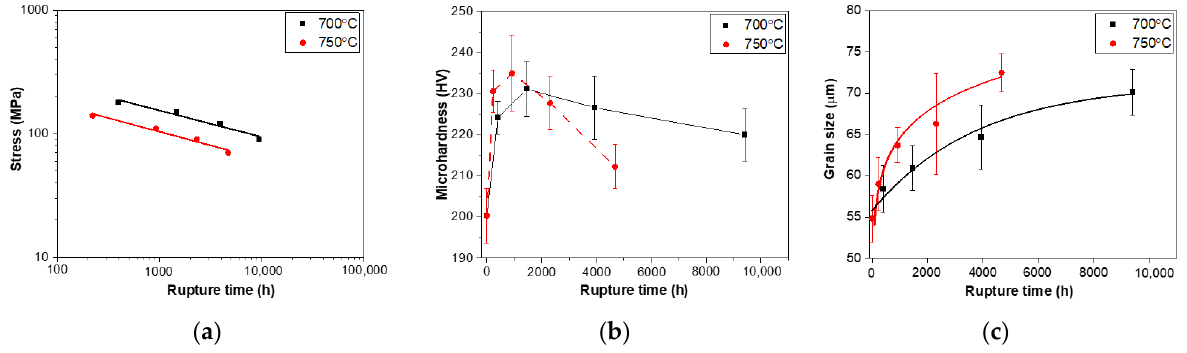
Figure 1. ( a ) The log-log plot of stress versus rupture time, ( b ) microhardness versus rupture time, and ( c ) grain size versus rupture time.